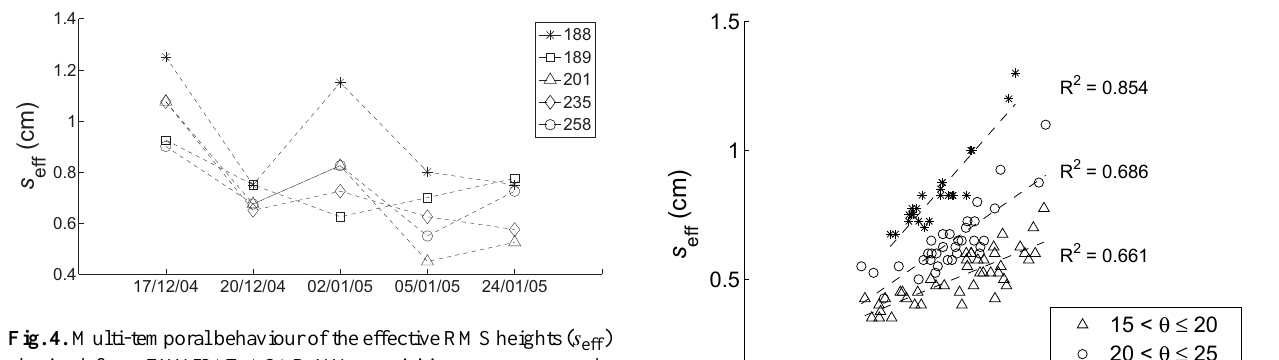
Fig. 6. Box plot of effective correlation lengths ( s e(cid:11) ) per site according to the index shown in Table 1.